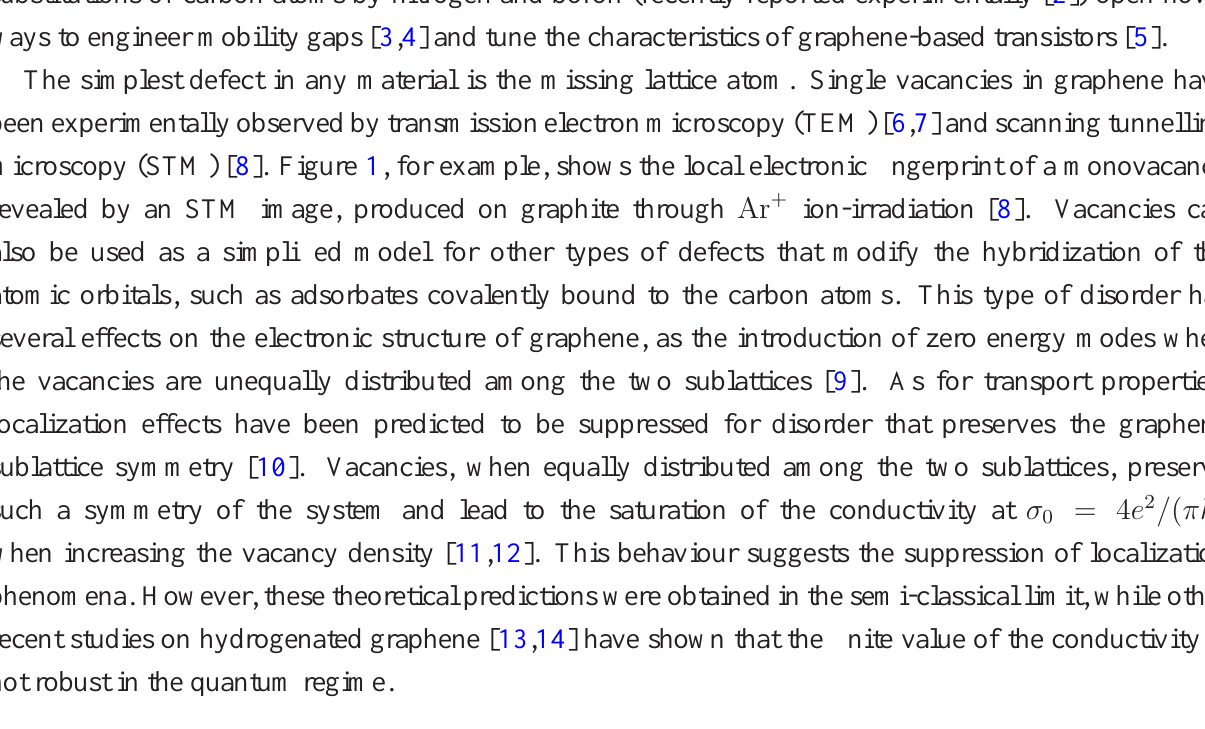
Figure 1. transmission electron microscopy (STM) picture of a single vacancy on graphite. By courtesy of J.M. Gomez-Rodriguez